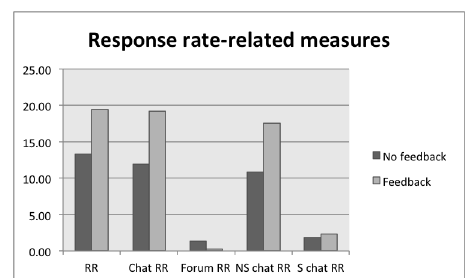
Figure 5. Comparison of Feedback and No-Feedback teams on Response Rate (RR) -related measures.